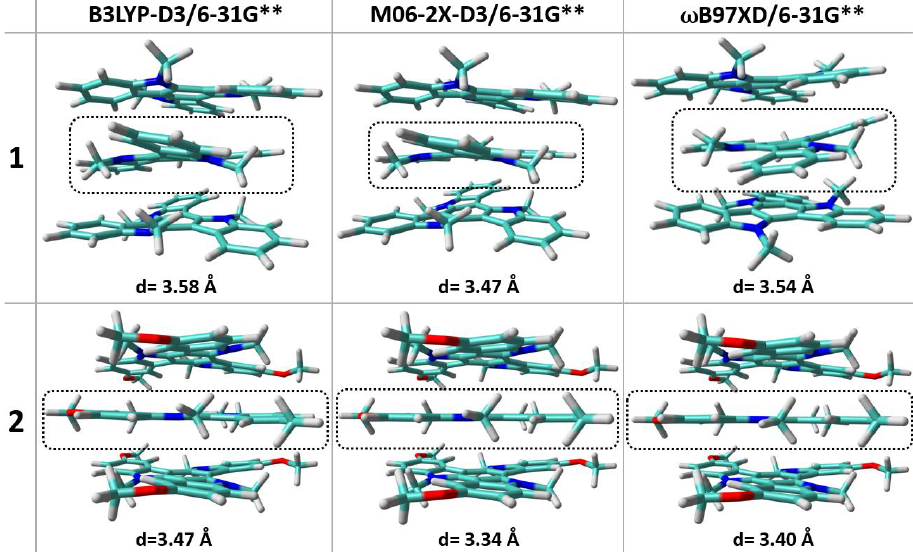
Figure 6. DFT-computed global minimum structures for a trimer model of 1 and 2 . The average centroid – centroid distance of the central aromatic rings between adjacent molecules is also shown.